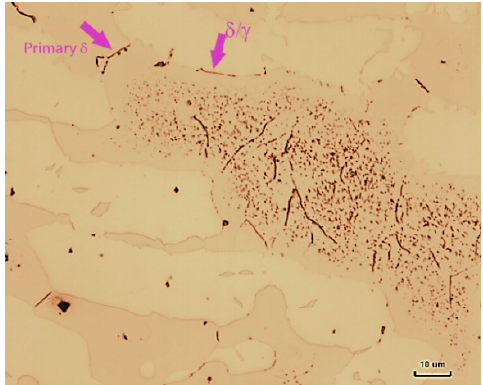
Figure 11. Preferential locations for precipitation of nitrides in the HAZ: primary ferrite grain boundaries, δ / ɣ boundaries and in the ferrite grains.